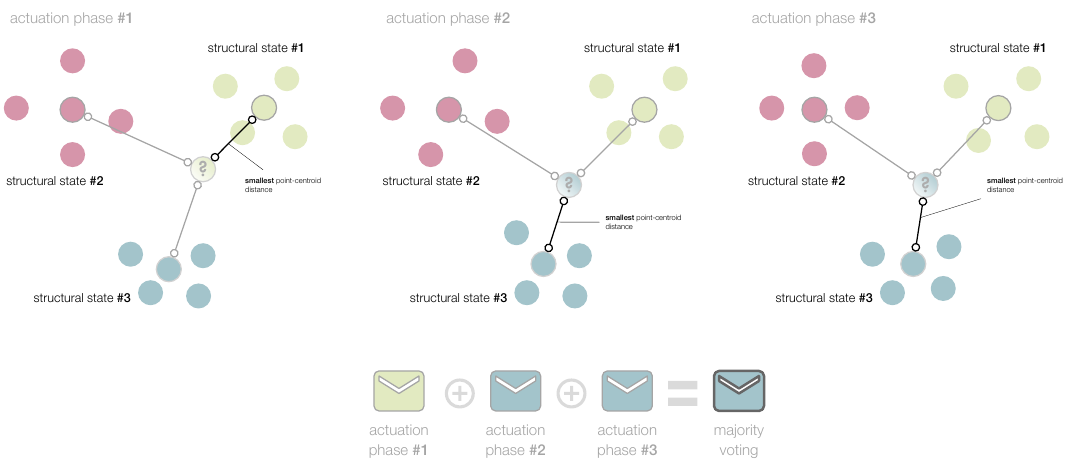
Figure 6. In the majority voting, the strategy of the smallest point-centroid distance is performed per actuation phase. The current structure to diagnose is associated to the most voted structural